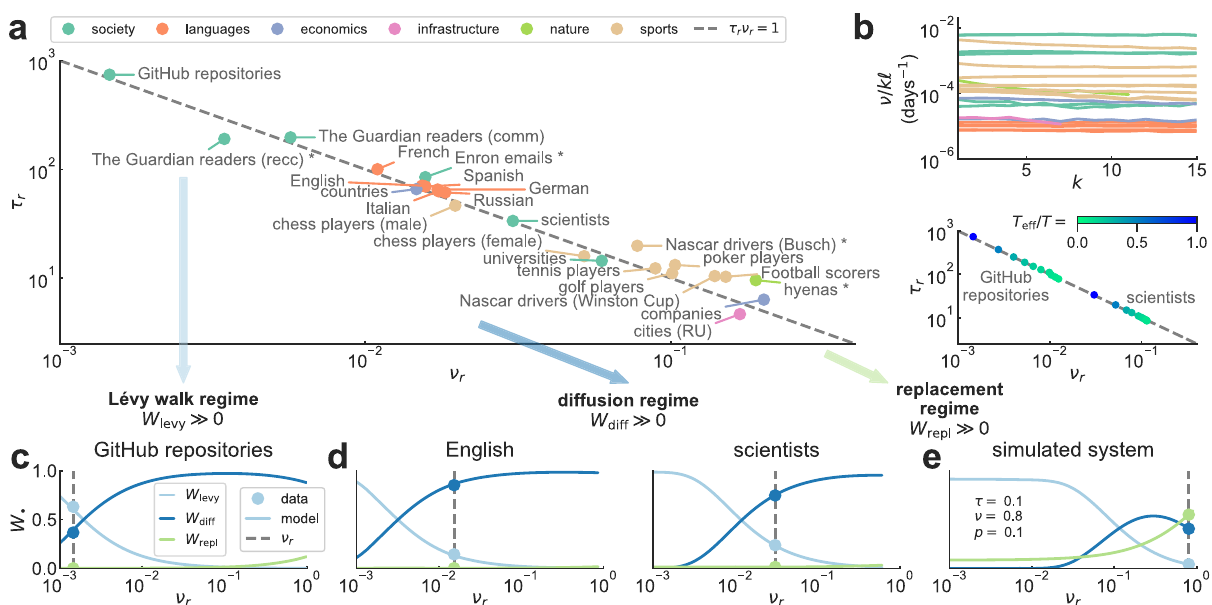
Fig. 3 Model uncovers regimes of dynamical behavior in open ranking lists. a Rescaled model parameters τ r and ν r in open ranking lists, obtained from fi tted parameters τ and ν , relative ranking list size p , and mean turnover rate _ o [see Eq. (5) and SI Section S5; only systems with _ o > 10 (cid:2) 3 are shown]. Values collapse onto the universal curve τ r ν r = 1, so an inverse relationship between displacement and replacement is enough to emulate empirical rank dynamics (asterisks denote datasets that are farther away from the universal curve than bootstrapped model simulations; see SI Fig. S20). b (Top) Rate of element replacement ν / k ℓ when subsampling data every k observations of length ℓ (see SI Table S1 and SI Section S5). Online social systems have the largest rates, followed by sports and languages (SI Table S2). (Bottom) Parameters τ r and ν r for T eff = ⌈ T / k ⌉ subsampled observations (all datasets in SI Fig. S22). By subsampling ranking dynamics, systems move downwards along the universal curve while keeping a constant replacement rate. c – e Average probability that an element changes rank by Lévy walk ( W levy ), diffusion ( W diff ), or is replaced ( W repl ) between consecutive observations in the data. Probabilities are shown both for selected datasets (dots), and for the model moving along the curve τ r ν r = 1 with the same p and _ o as the data (lines) (for rest of systems see SI Fig. S17). The simulated system in ( e ) is the model itself for given values of τ , ν , and p (shown in plot). The model reveals a crossover in real-world ranking lists between a regime dominated by Lévy walks (b) to one driven by diffusion ( c ). Although not seen in data, the model also predicts a third regime driven by replacement ( d